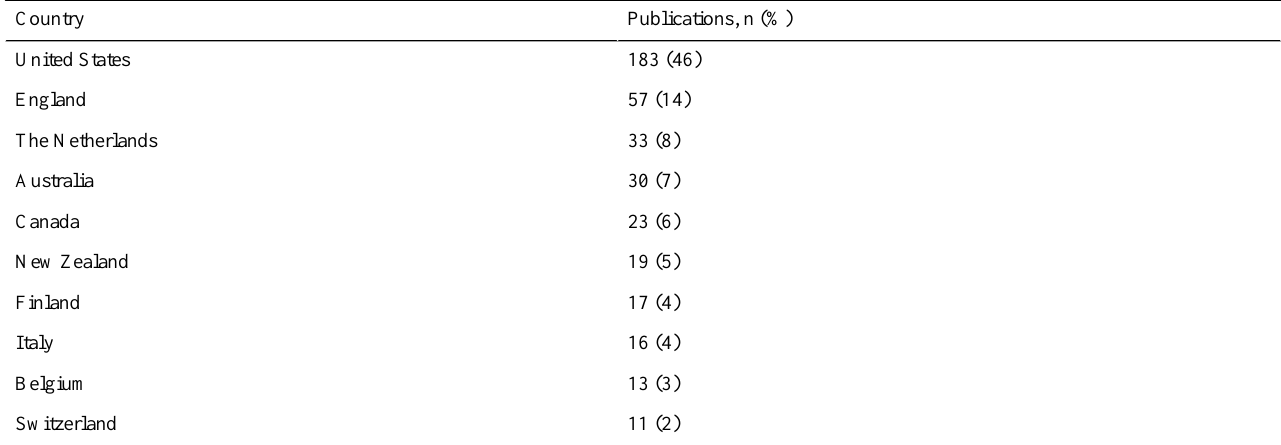
Table 2. Persuasive technology for behavior change, scholarly papers by